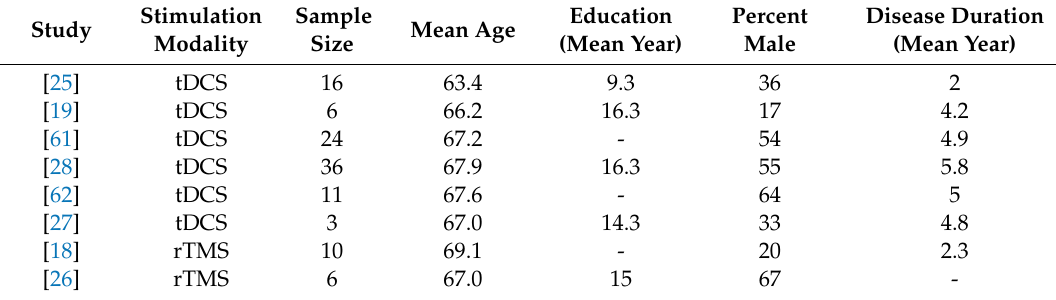
Table 2. Study sample